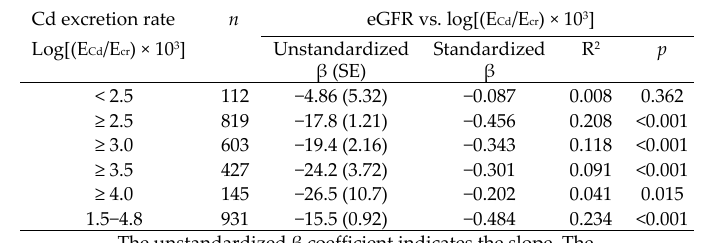
The unstandardized β coefficient indicates the slope. The standardized β coefficient indicates the strength of the as- sociation of eGFR with log[(E Cd /C cr )×10 5 ]. Log